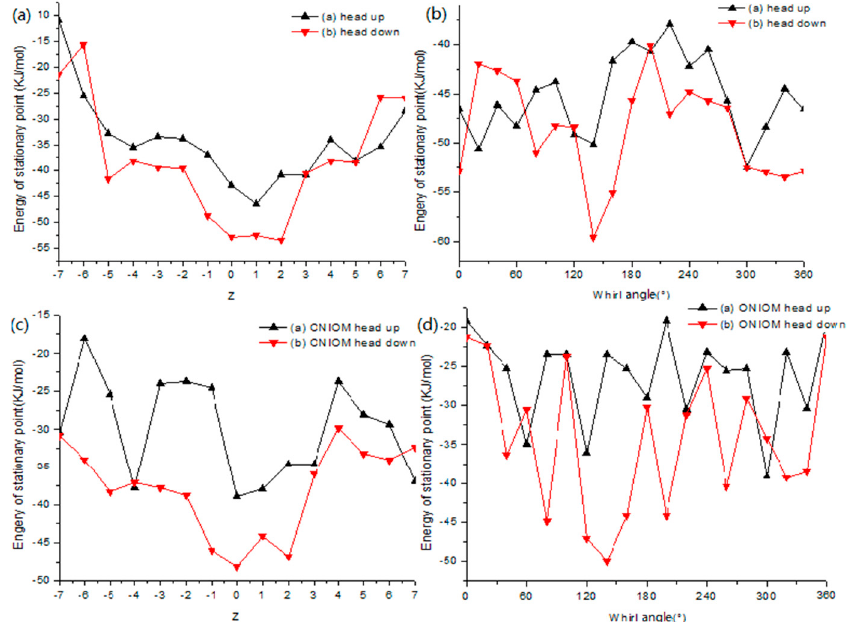
Figure 7. Binding energies between SA and β -CD calculated by PM3 method: ( a ) in different positions; ( b ) at different angles. The binding energies between SA and β -CD calculated by ONIOM (B3LYP/6-3lG:PM3) method: ( c ) in different positions; ( d ) at different angles. Table 3. Binding energies for SA/ β -CD calculated by PM3 method.